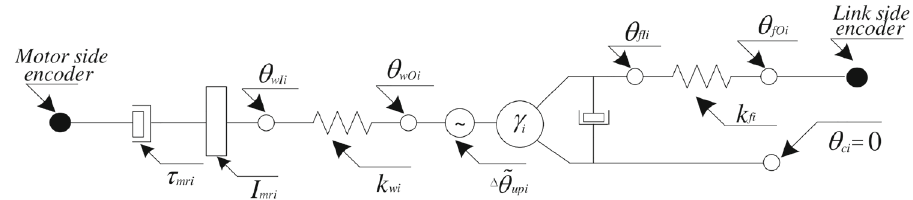
Fig. 1 Harmonic drive compliance